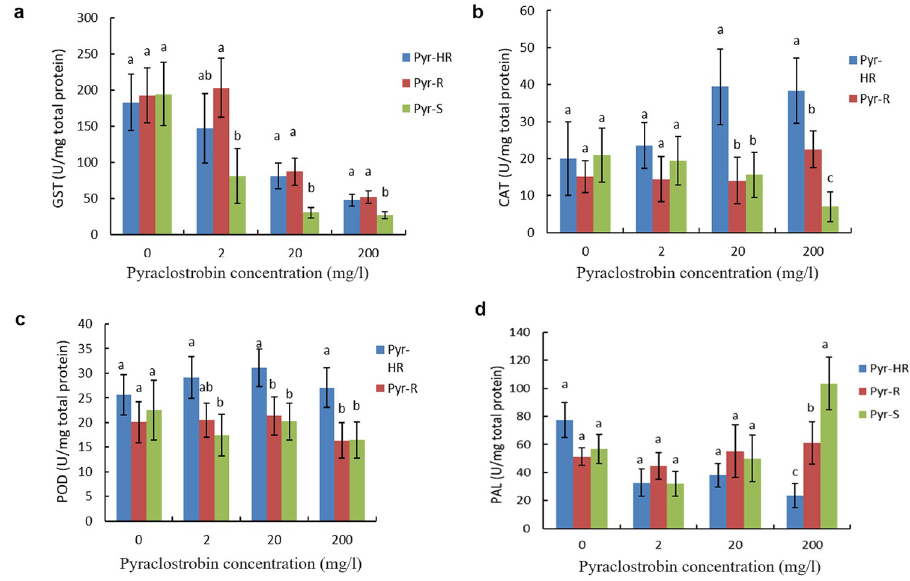
R = resistant, and HR = highly resistant.